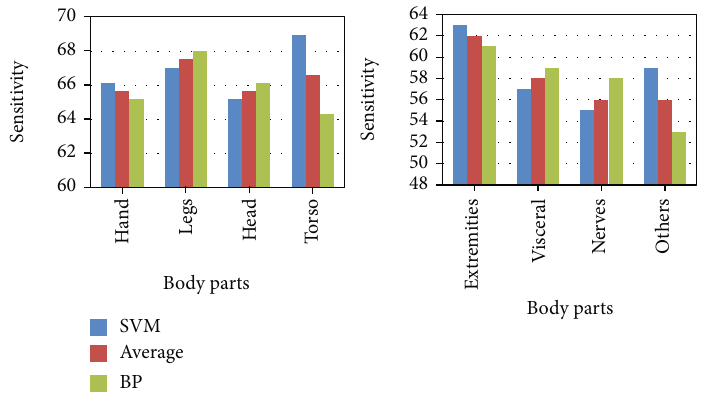
Figure 4: Recognition sensitivity of di ff erent injury sites in football.